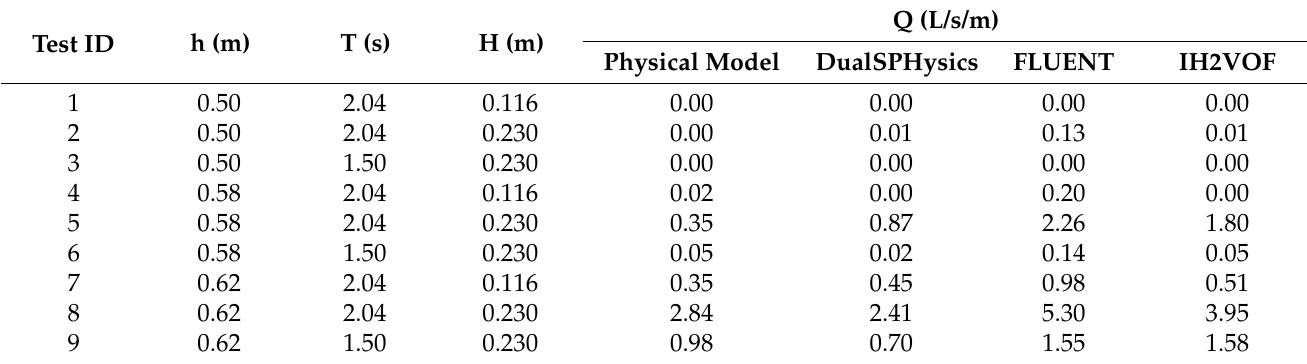
Table 13. Mean wave overtopping discharge calculated by physical and numerical models.